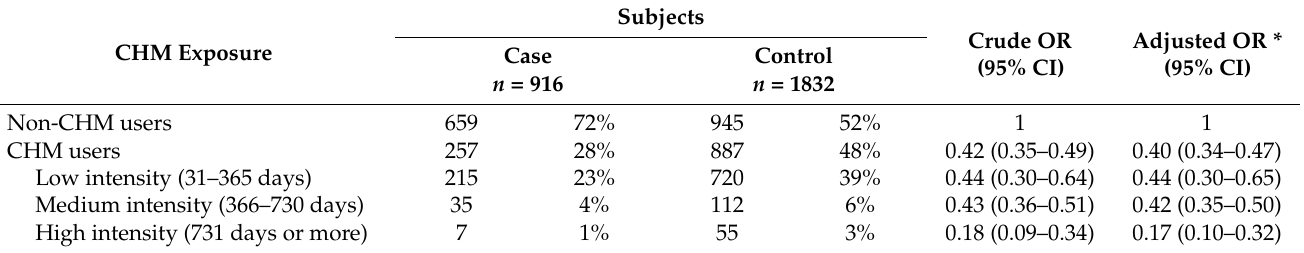
Table 2. The association between SS onset and use of CHM.